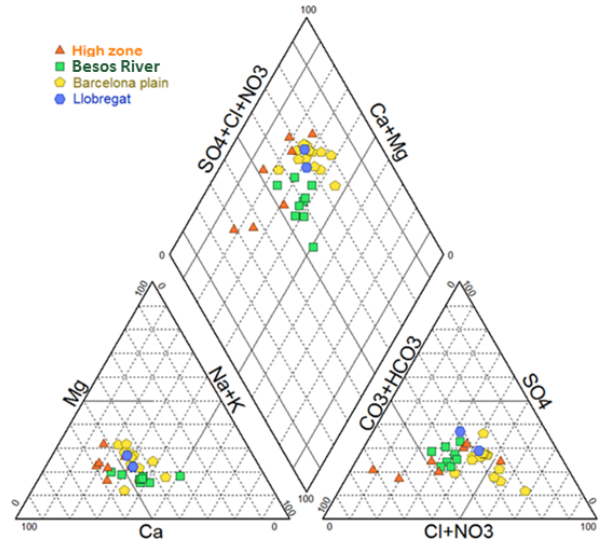
Figure 4. Piper diagram of samples.